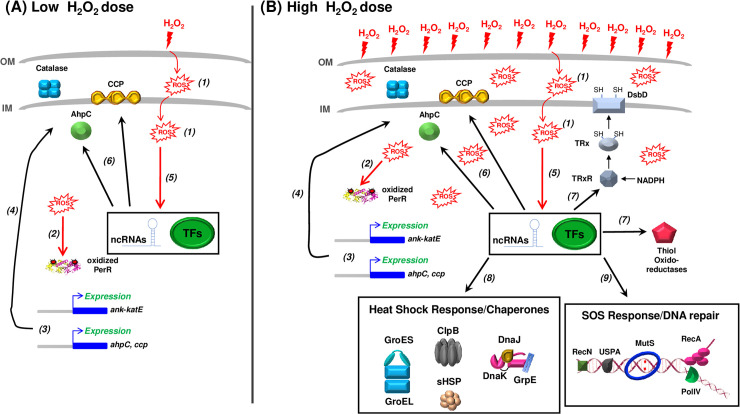
Schematic representation of the pathogenic Leptospira response to hydrogen peroxide.In the presence of low H2O2 dose (A), ROS are produced in the cell (1), PerR is oxidized (2) and dissociates from DNA regions in the locus of the three peroxidase-encoding genes (ank-katE operon, ahpC, ccp), leading to their derepression (3) and increased production of catalase, AhpC and CCP (4). Other transcriptional regulator (TFs) and non-coding RNAs whose expression is affected in the presence of ROS (5) probably participate in the H2O2-induced increase of AhpC and CCP production (6). As a result, the activities of catalase, AhpC and CCP allow maintaining ROS at a harmless level. The increased expression of heme biosynthesis genes, which is PerR-independent and probably participates in the peroxidase activities of catalase, AhpC and CCP, is not represented here. When the level of ROS overwhelms the detoxification capacity of the up-regulated peroxidases and becomes damaging for the cellular constituents (B), in addition of a higher production of catalase, AhpC and CCP, other machineries are up-regulated such as thiol oxido-reductases (including thioredoxin, DsbD, etc.) (7), molecular chaperones (8) and DNA repair proteins (9). The increased expression of the aforementioned machineries is PerR-independent and probably involves other transcriptional regulators (TFs) and noncoding RNAs.